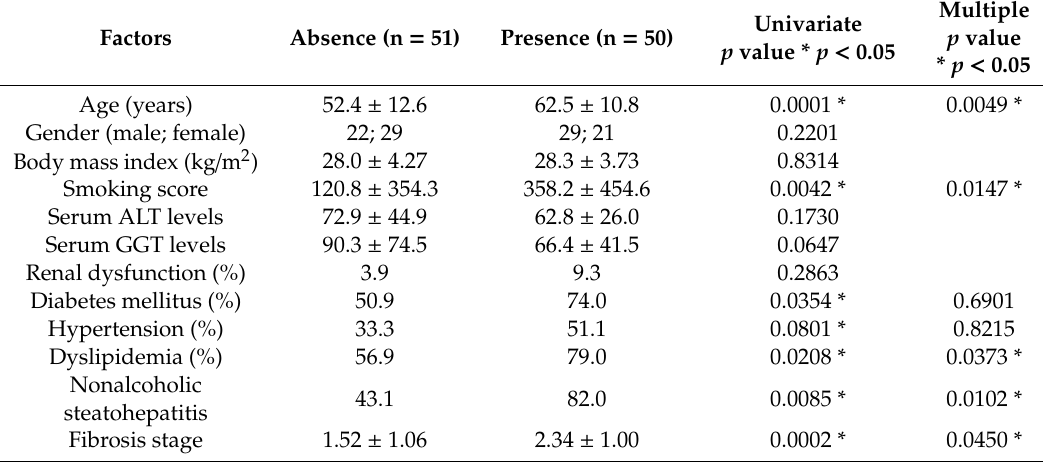
Table 2. Univariate analysis and multiple regression analysis of potential risk factors for coronary artery stenosis in patients with NAFLD. *, statistical significance, p value < 0.05 in Univariate and Multiple regression analysis,